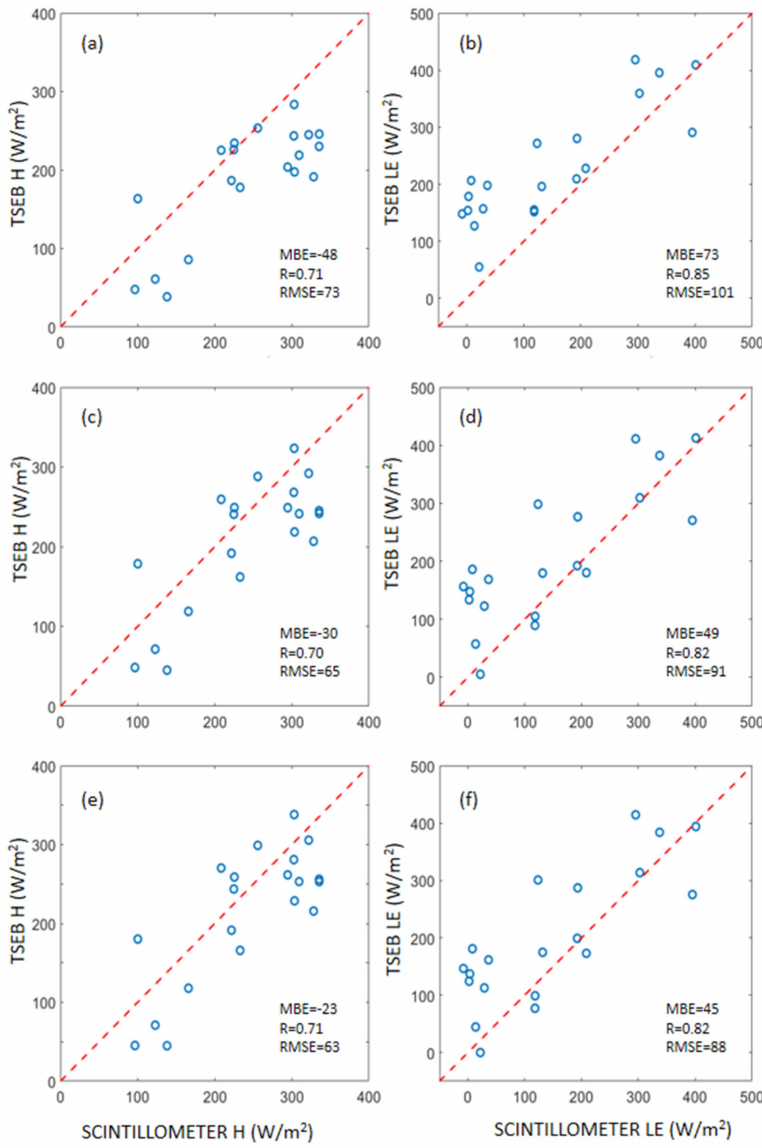
Figure 9. Sensible and latent heat fluxes scatterplots of the comparison between the LAS grid scale measurements and TSEB predictions based on MODIS products for: simple averaging ( a , b ); area weighted method ( c , d ); and footprint weighted method ( e , f ) (at MODIS overpass